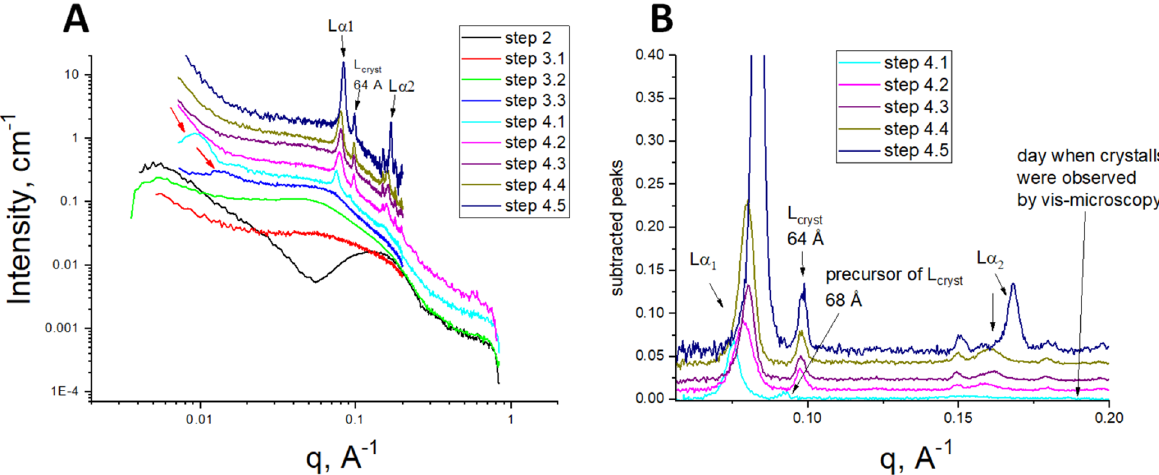
Figure 3. Transformation of the SAXS curves for the crystallization system during the different steps of the crystallization process. ( A ) The SAXS curves related to different steps of the crystallization process. The red arrows in the small angle region indicate the interference peaks from the lipid/detergent smectic phase (curve designations are given in the legend; steps numbering is described in Fig. 1). ( B ) The peaks extracted from the SAXS curves (part A ) by subtraction of the baseline. The curves are scaled to separate them vertically for better visualization. The black arrows “Lα 1 ” and “Lα 2 ” (shown in both A , B ) indicate the lamellar peaks of the first and second order; the other black arrow “L cryst 64 Å” indicates the peak from the local lamellar phase bonded with the protein surface, the spacing of this L cryst is 64 Å. The arrow “68 Å” indicates the precursor of the L cryst